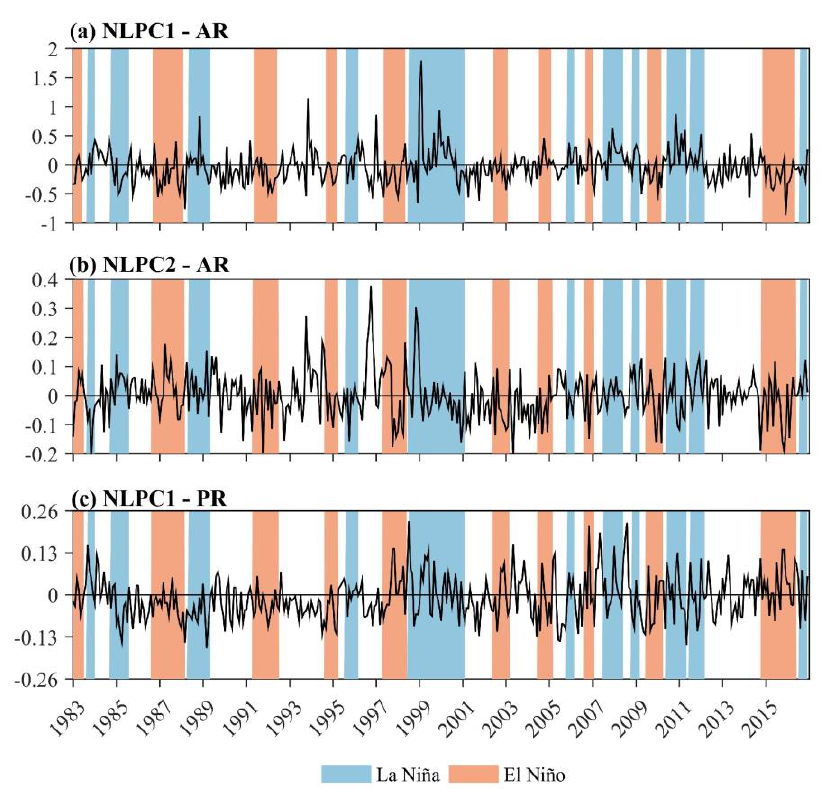
Figure 6. The 1983–2016-time series of the NLPCs for Andean Region (AR) and Pacific Region (PR): ( a ) NLPC1-AR, ( b ) NLPC2-AR, and ( c ) NLPC1-PR .